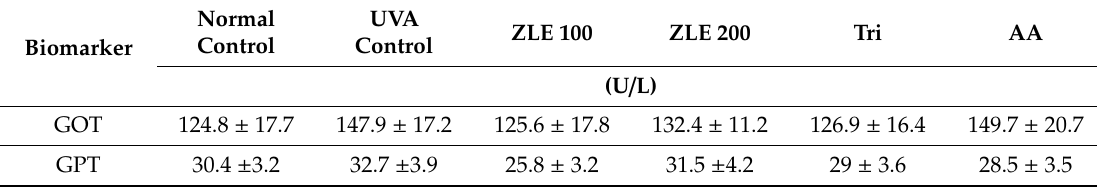
Figure 5. E ff ects of enzyme-treated Z. latifolia extract (ZLE) and tricin on body weight in UVA-irradiated mice. The body weight was measured every 3 weeks. Data are expressed as the mean ± SE. Table 1. E ff ect of enzyme-treated Z. latifolia extract (ZLE) and tricin on hepatotoxicity biomarkers in UVA-irradiated